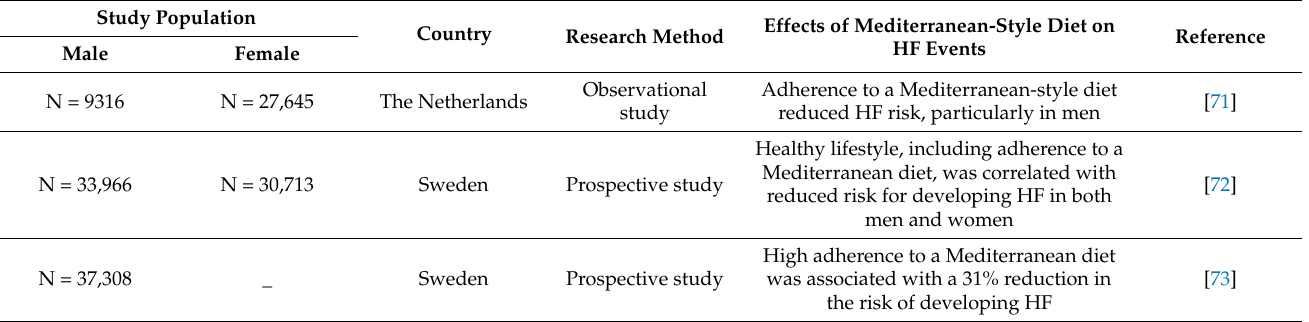
Table 2. Adherence to a Mediterranean-style diet reduces HF